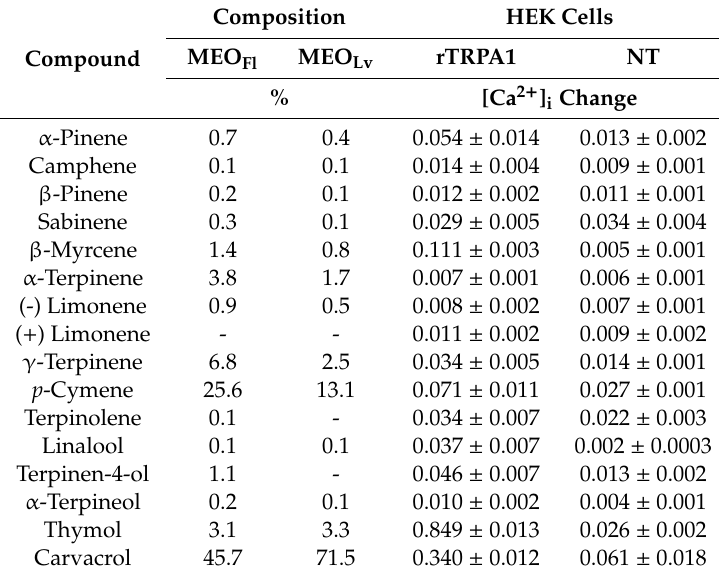
Table 4. Relative content of constituent monoterpenes in MEO Fl and MEO Lv and their e ff ects on [Ca 2 + ] i flux in HEK rTRPA1-transfected cells.